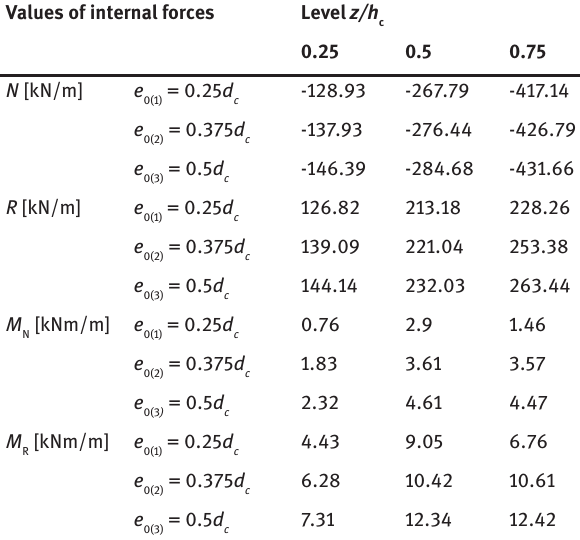
Table 5: Extreme values of internal forces in the wall of the silo with diameter d =10 m at selected levels from symmetrical pressure, c taking into account the local load.